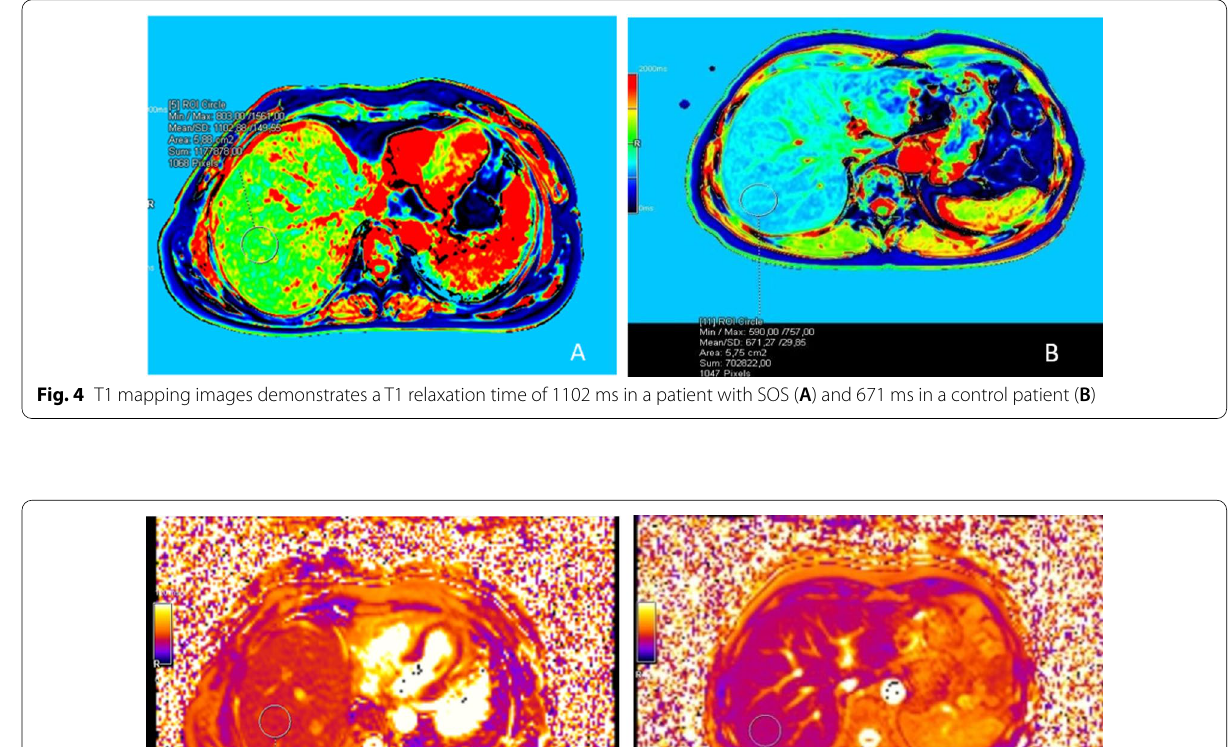
Table 3 Diagnostic accuracy of liver stiffness and cT1 relaxation time for SOS Patient cutoff